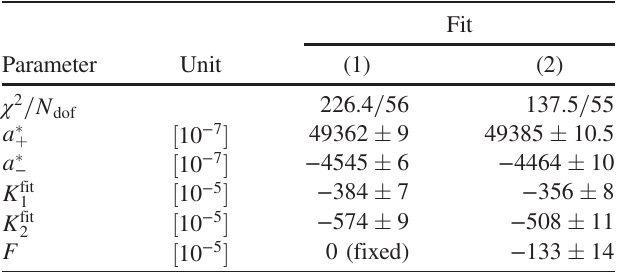
TABLE V. Summary of fits to the spin tune map with allowance for orbit distortion effects. Fit 1 uses Eq. (71) with F ¼ 0 , while Fit 2 allows in addition for a cross talks of solenoids S 1 and S 2